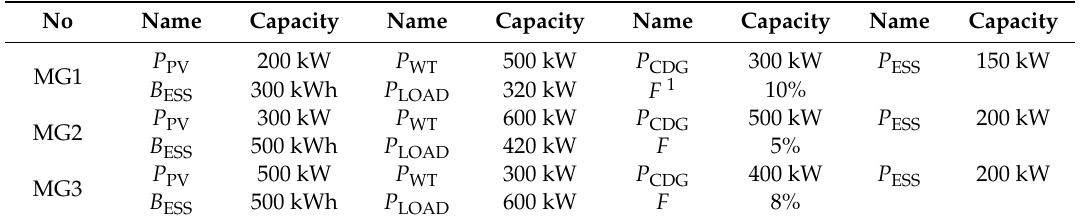
Table 1. System parameters.